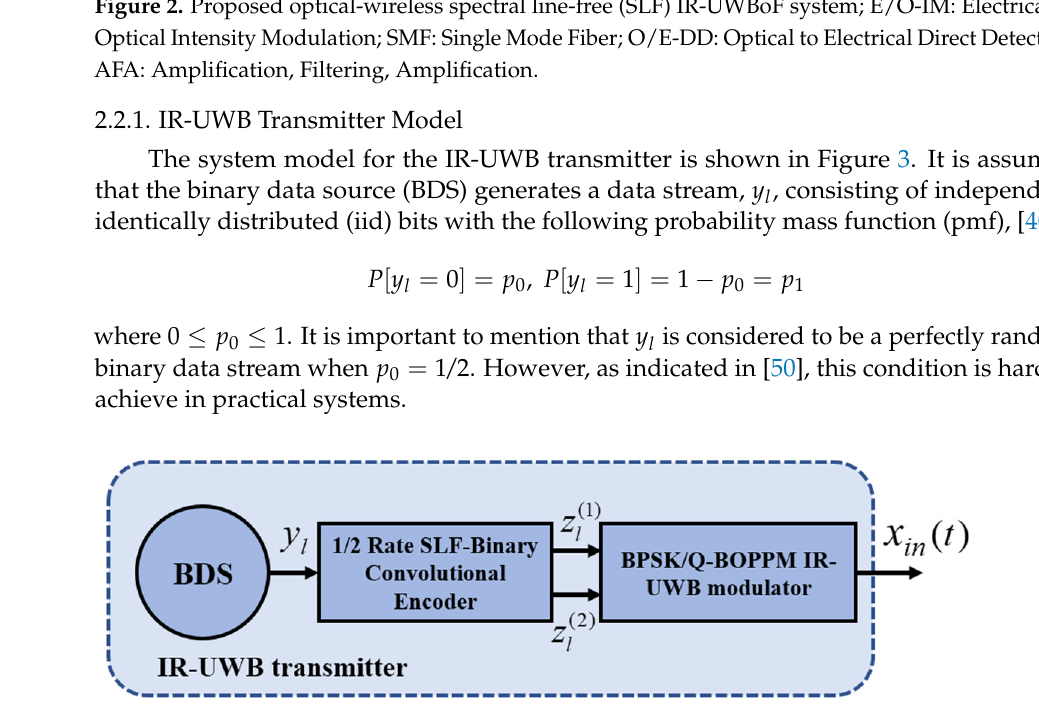
Figure 2. Proposed optical-wireless spectral line-free (SLF) IR-UWBoF system; E/O-IM: Electrical to